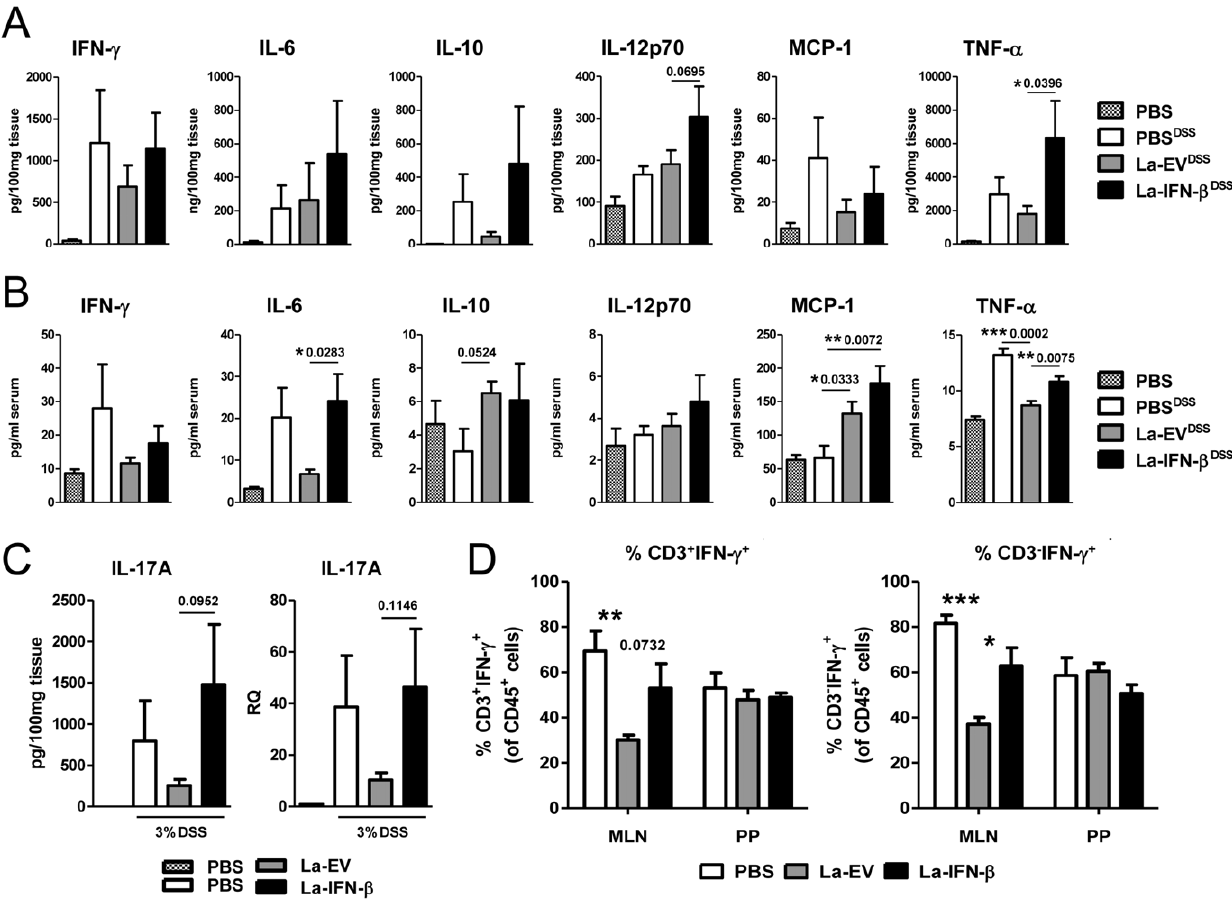
Figure 4. Elevated levels of inflammatory cytokines in mice pretreated with La-IFN- b over La-EV. ( A ) 2 cm of the distal colon was removed and weighed from colitic mice pretreated with PBS, La-EV or La-IFN- b (and a no DSS control group) and cultured overnight (n=10). IFN- c , IL- 6, IL-10, IL-12p70, MCP-1 and TNF- a cytokine levels were assayed by CBA and standardized to concentration per 100 mg tissue. ( B ) Serum was assayed for the presence of inflammatory cytokines by CBA on day 7 of DSS administration (n=5). ( C ) Measurement of IL-17A in colonic tissue culture (as outlined in Fig.4A) by CBA and the relative quantification of IL-17A mRNA in the distal colon was measured by RT-PCR. For RT-PCR, the colitic groups were compared relative to a no DSS control (RQ=1) and HRPT was used as an endogenous control. ( D ) Cells isolated from the MLNs and PPs of colitic mice were stimulated with PMA (10 ng/ml) and ionomycin (1 m M/ml) for 5 h with the addition of Brefeldin A after 2 h. The cells were then stained for CD3 and fixed for intracellular detection of IFN- c . Data is presented as %CD3 + IFN- c + or %CD3 2 IFN- c + cells in the CD45 + population. The data is represented as the mean 6 SEM. * p , 0.05, ** p , 0.01, *** p , 0.001.